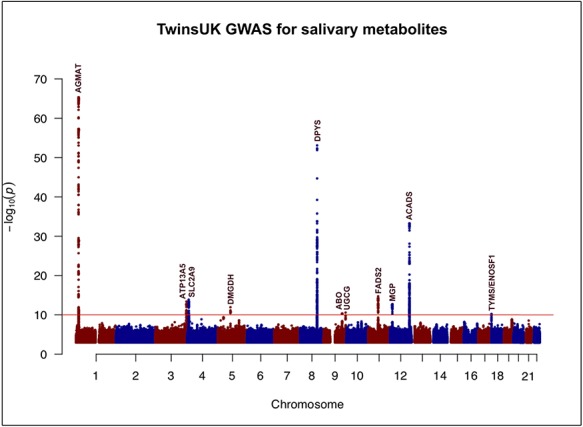
Manhattan plot illustrating the findings of the discovery phase (TwinsUK) of the genome-wide association study for salivary metabolites. The red horizontal line demarcates the study-wide significance threshold of P = 10−10. Eleven loci surpassed the study-wide significance threshold. The loci are referred to by the name (s) of the overlapping or the nearest gene(s).